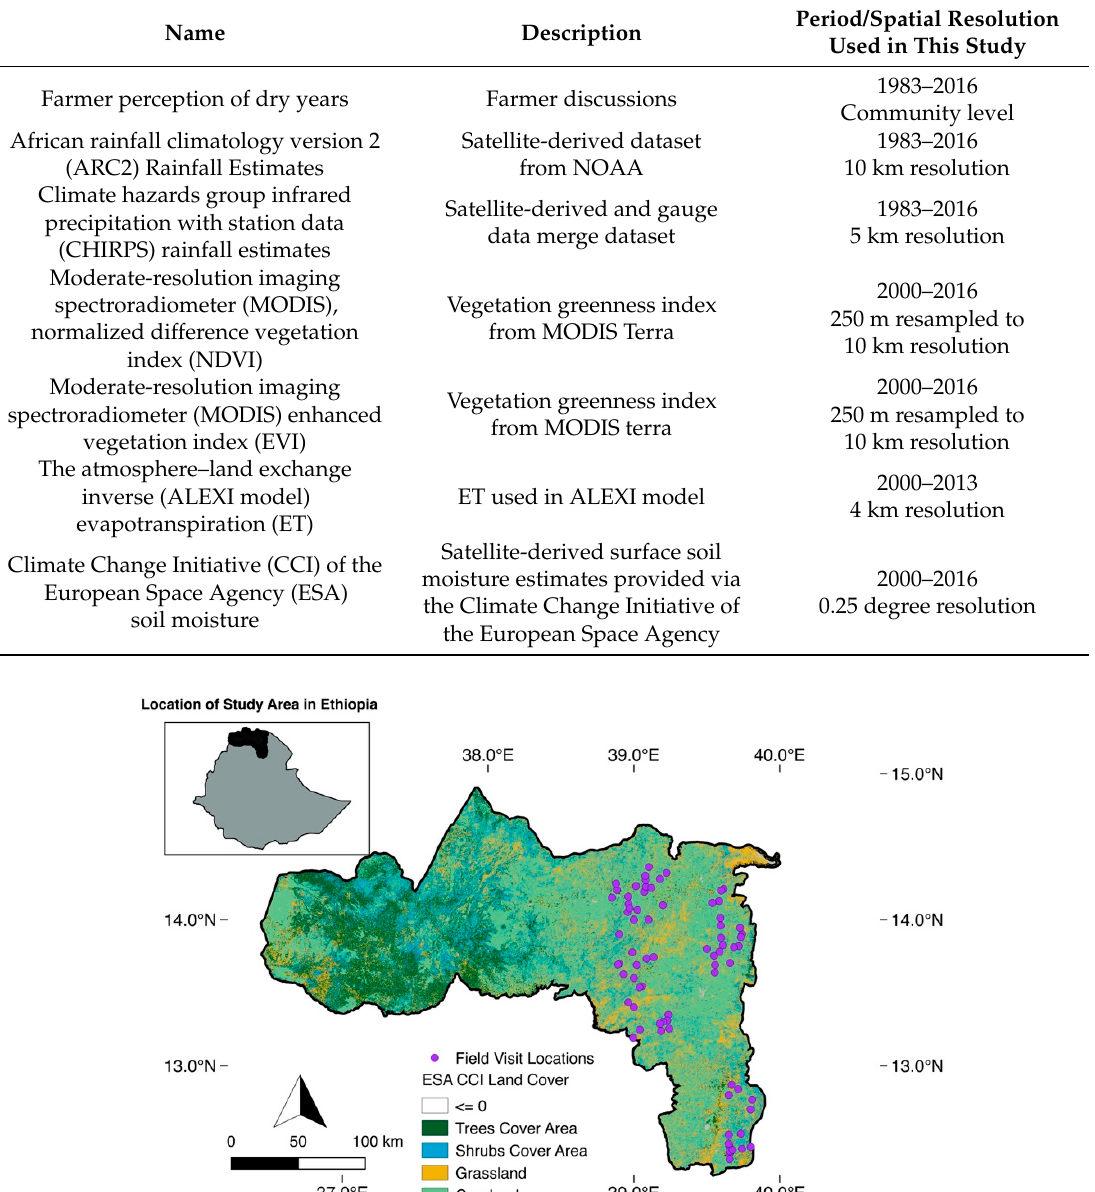
Table 1. A description of dataset characteristics used for the study.